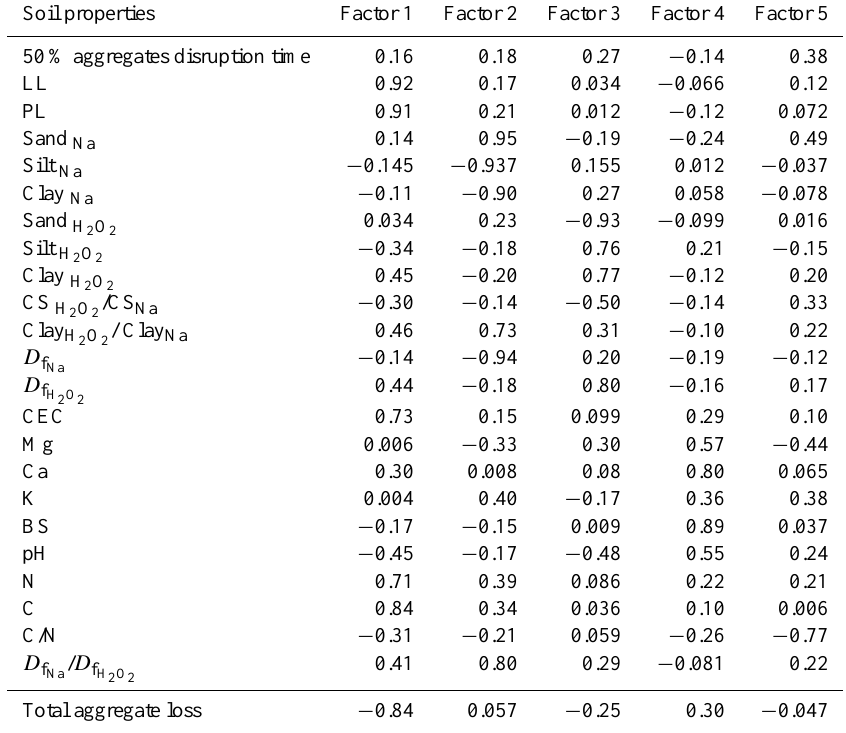
Table 7. Proportion of variance (varimax rotation) for soil properties of the retained factors in topsoil samples ( n = 41). Soil properties